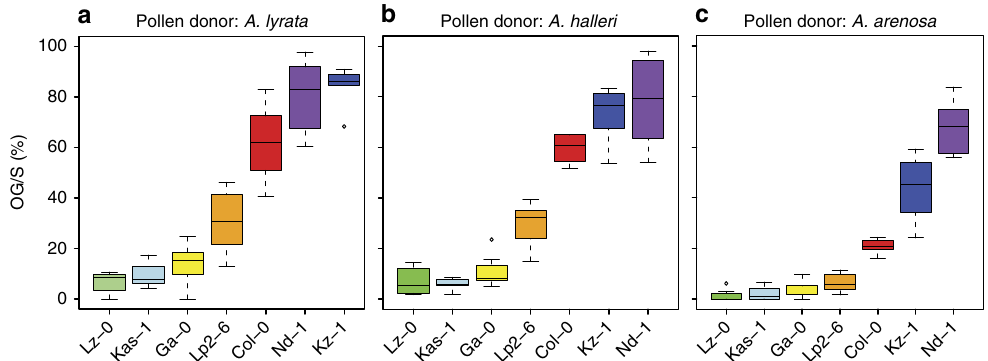
Figure 2 | Natural variation in PT reception with different interspecific pollen donors. ( a ) A subset of A. thaliana accessions pollinated with A. lyrata pollen. Per accession, four to eight siliques were analysed. Box plots are ordered by the mean OG/S value and colour-coded to facilitate comparison with b and c . ( b , c ) The same subset pollinated with pollen from A. halleri ( b ) and A. arenosa ( c ). The accessions show comparable OG/S with all three interspecific pollen